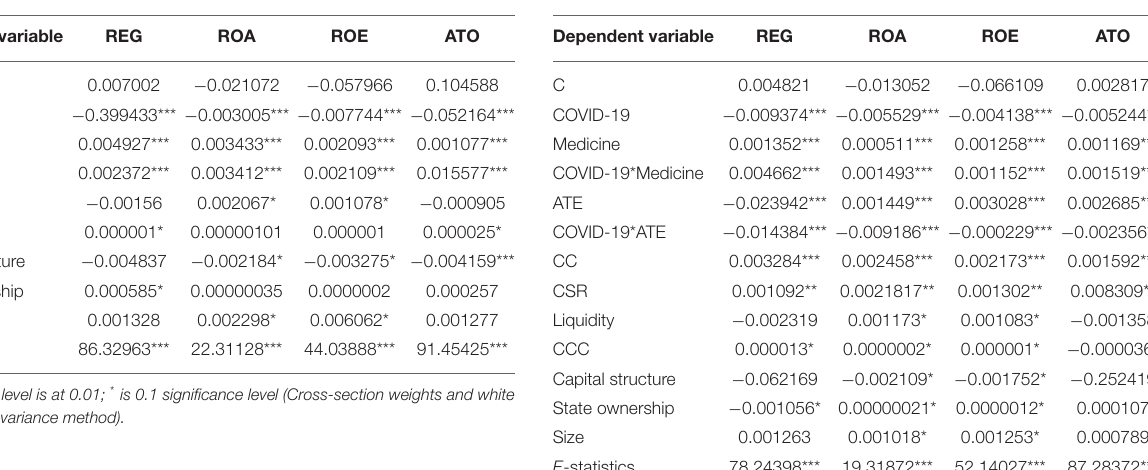
TABLE 4 | Generalized Linear Regression (GLR). TABLE 5 | Generalized linear regression with medicine and ATE